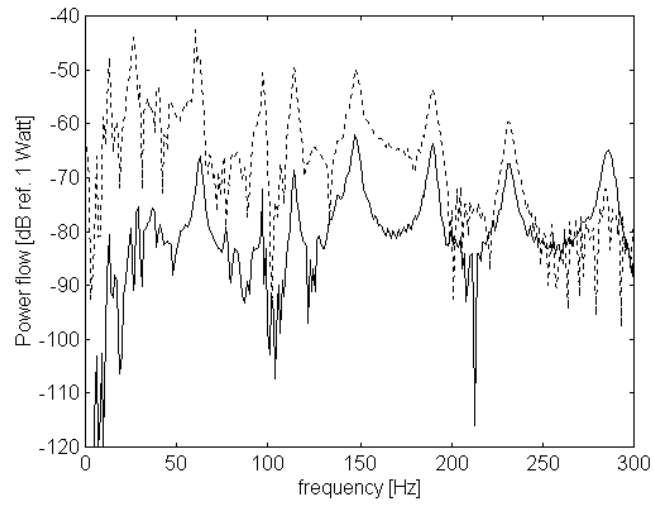
Fig. 7. SI components at a lower vibration level measured using PVDF patches. — Flexural SI; ··· longitudinal